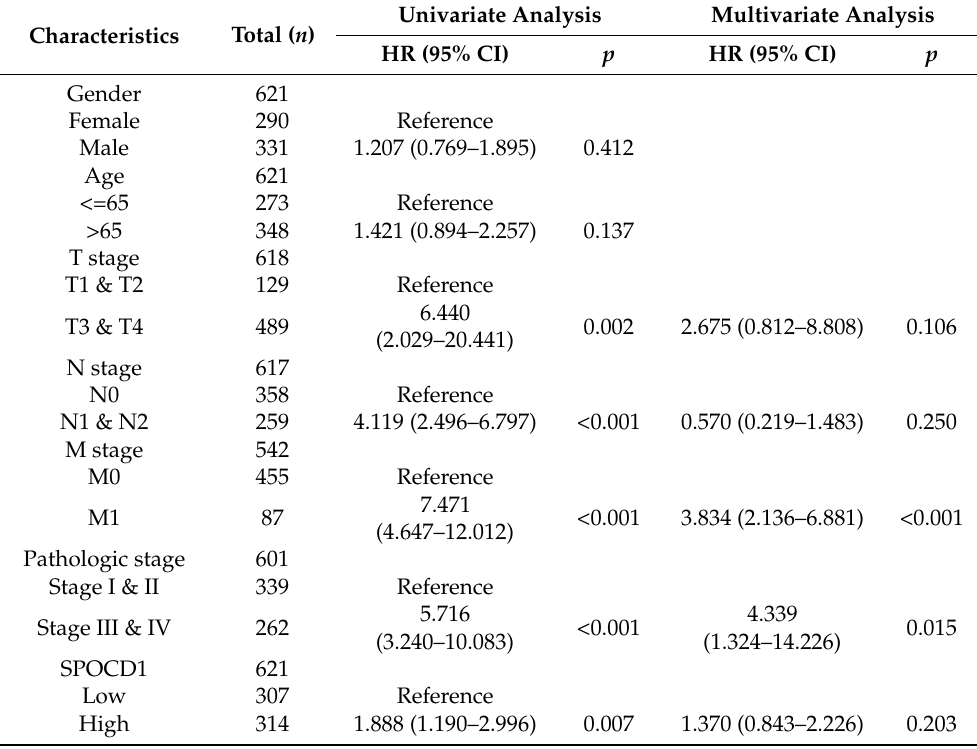
Table 3. The univariate and multivariate analysis of Disease Specific Survival